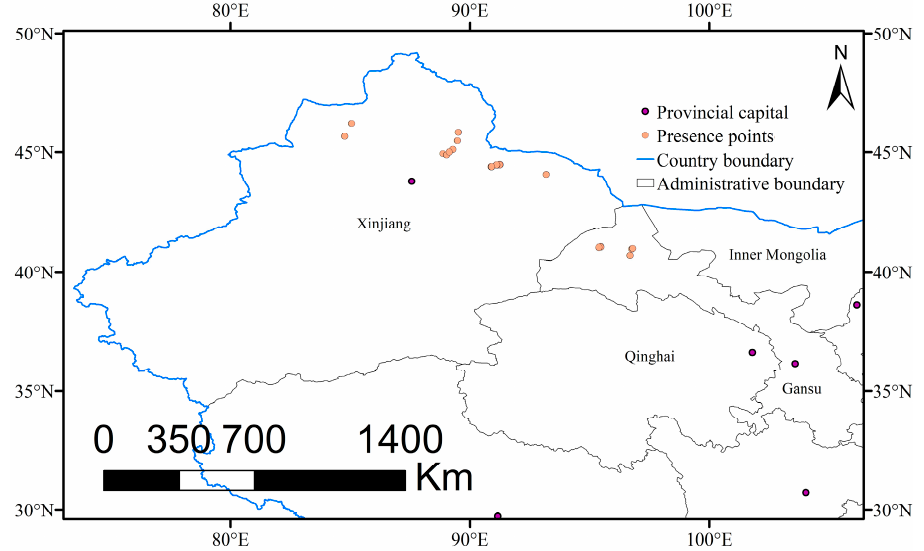
Figure 1. Occurrence data of Rheum nanum in China.